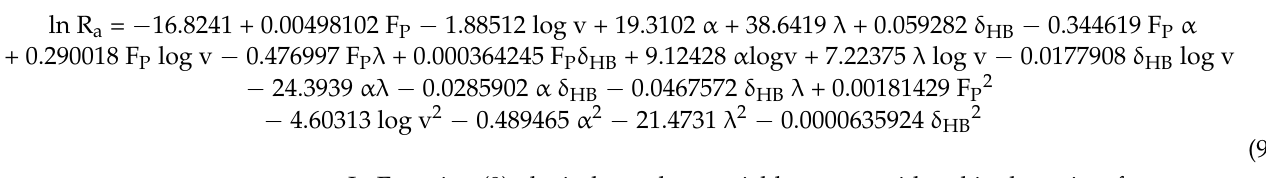
Figure 13. Depth of the surface layer: ( a ) machined workpiece — hardness HB = 200; ( b ) machined workpiece — hardness HB = 300; ( c ) machined workpiece — hardness HB = 350; and ( d ) machined workpiece — hardness HB = 400.